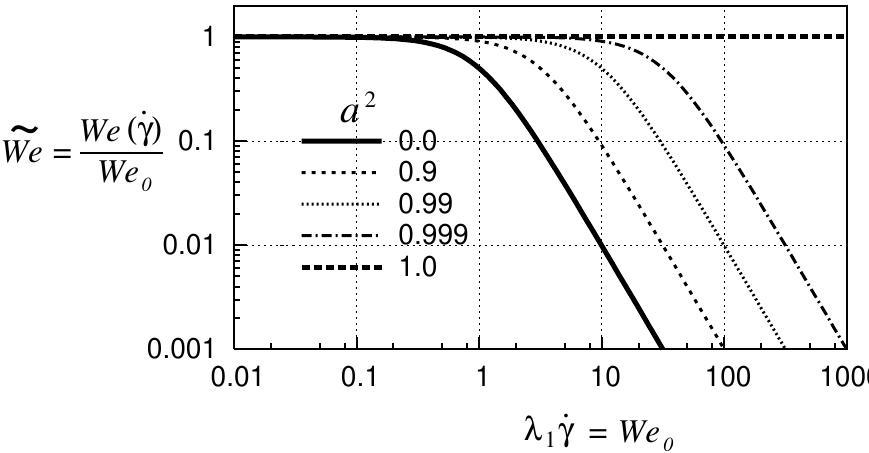
Figure 8. Shear-thinning index of the Weissenberg number as a function of the shear rate. It could easily be shown from (25) that for the Oldroyd-B and Oldroyd-A models, which have no shear-thinning viscosity, the original We ( ˙ γ ) = λ 1 ˙ γ is recovered. The low-shear limit Weissenberg number leads exactly to the same original linear